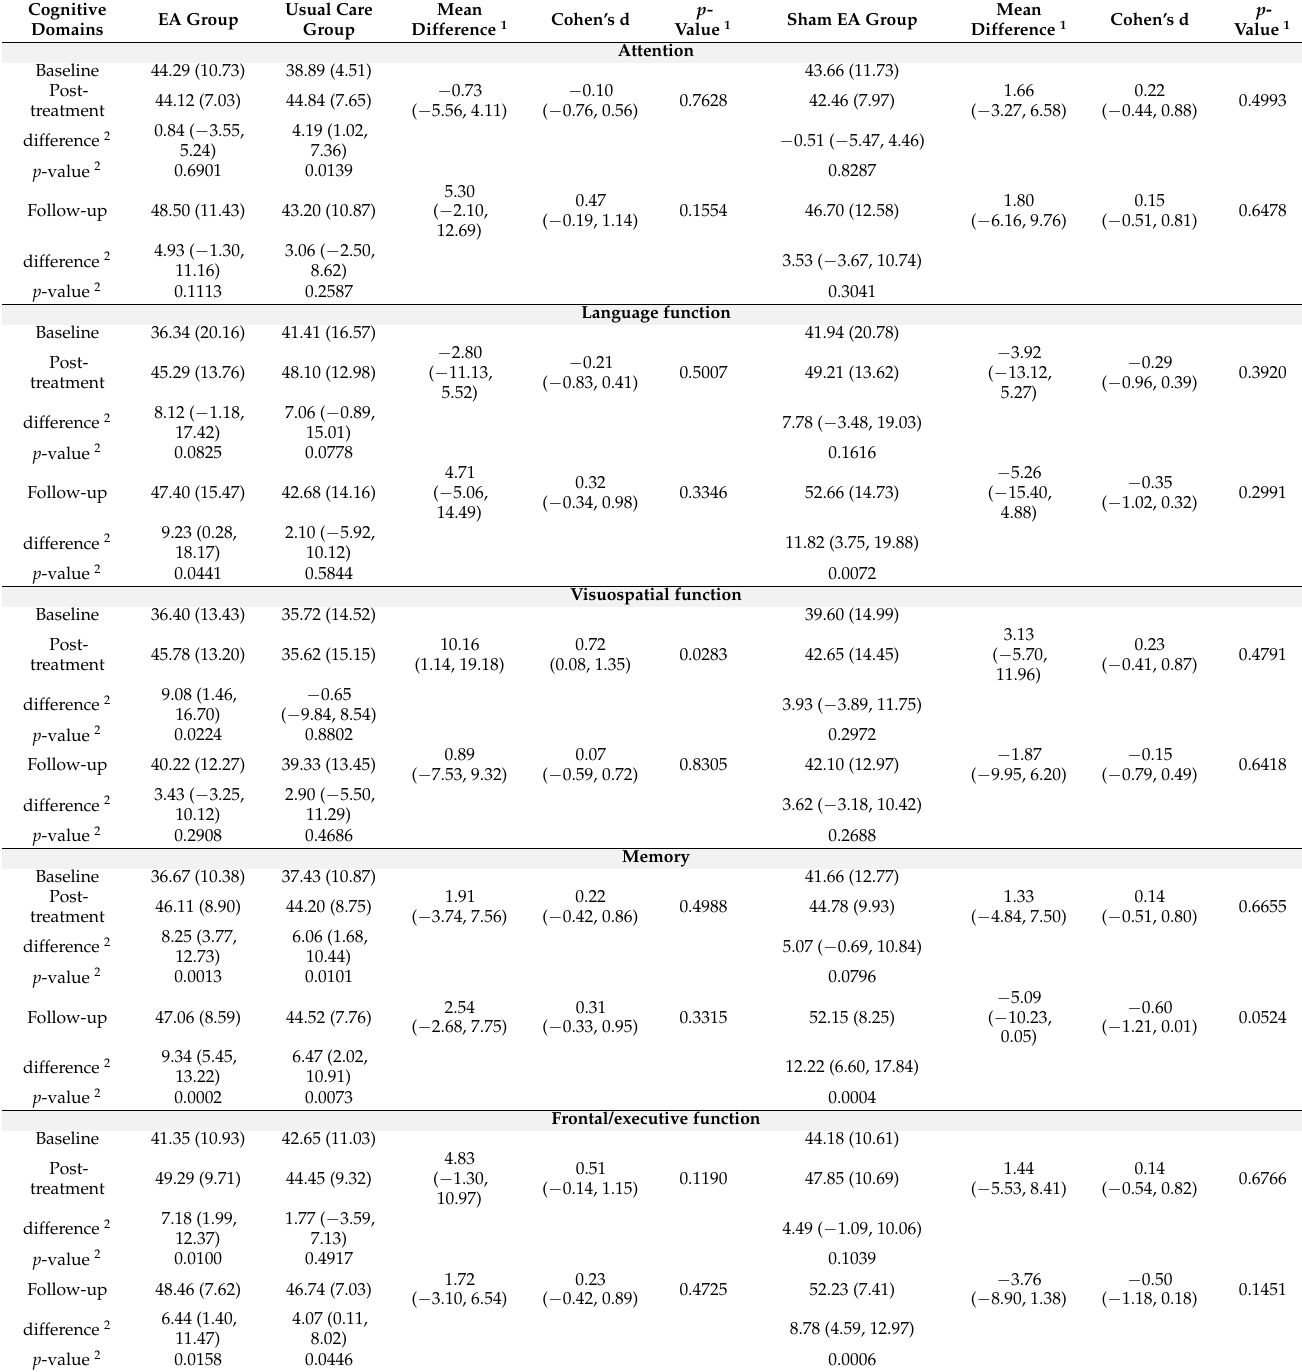
Table 2. Effects of 12-week EA Treatment on T scores of Five Cognitive Function Domains Calculated with Cognitive Tests Included in Seoul Neuropsychological Screening Battery II